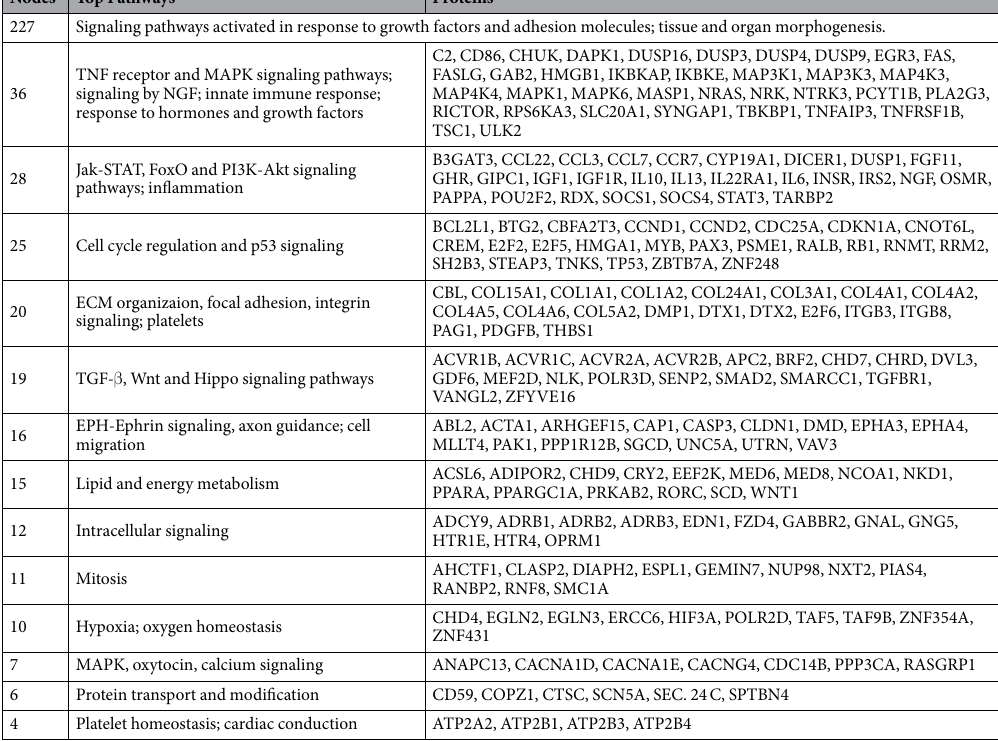
Table 4. Summary of main findings from the pathway analysis (by module) of the network created for shared target genes between top differentially expressed miRNAs in the Death/CLD group of CDH